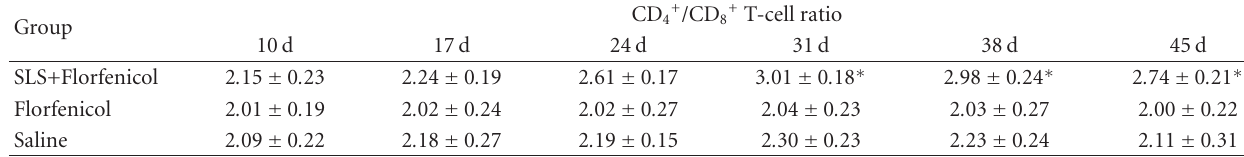
Table 6: Influence of SLS on CD 4+ /CD 8+ T-cell ratio of thiamphenicol-treated